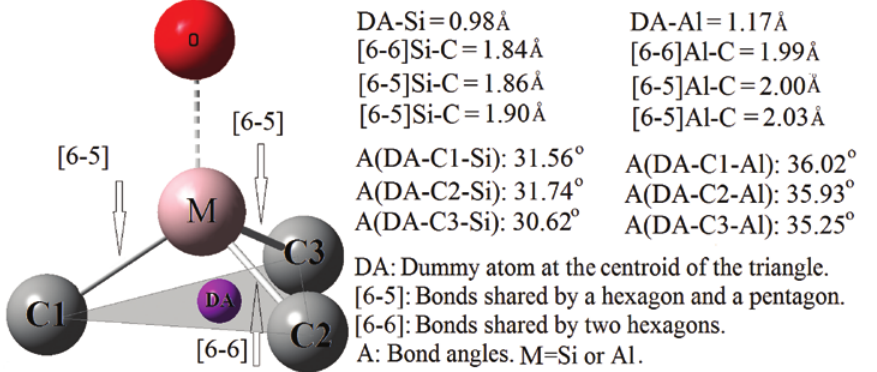
Figure 3: Pictogram of the interaction edge.